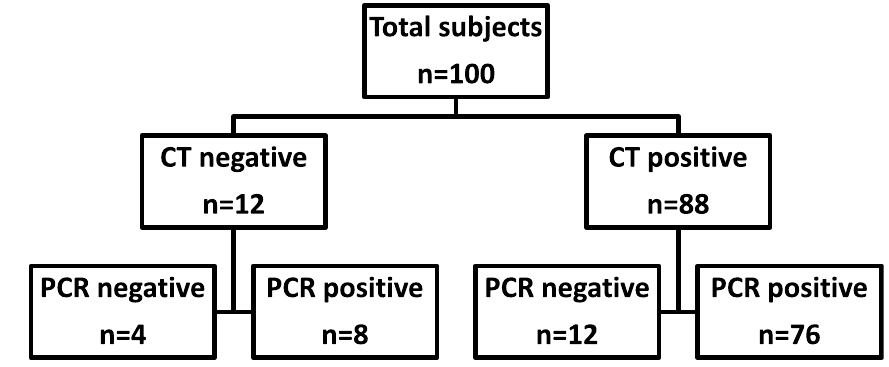
Fig. 1 Flow chart of studied